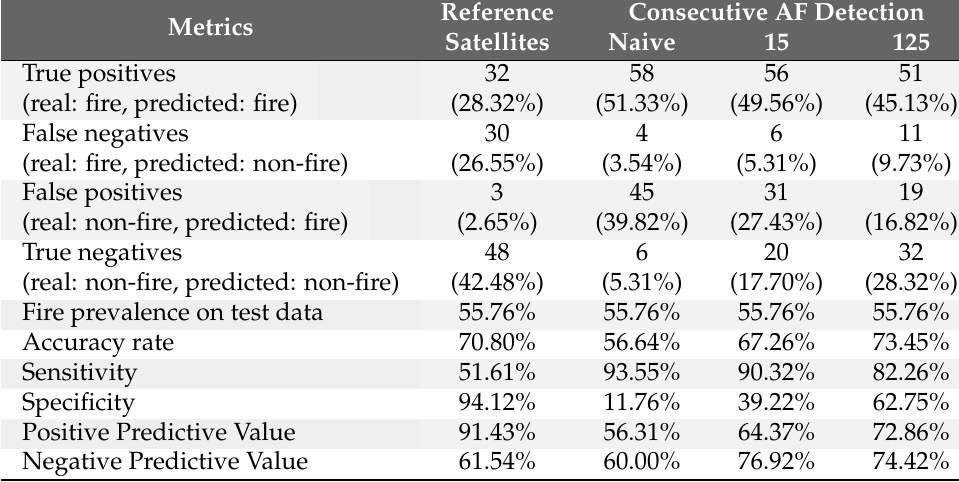
Table 3. Reference satellites (MODIS and VIIRS) and Final Model (FM) prediction assessment metrics by 1 (naive), 15 and 125 consecutive Active Fire (AF) detections. Results in absolute numbers and percentage.